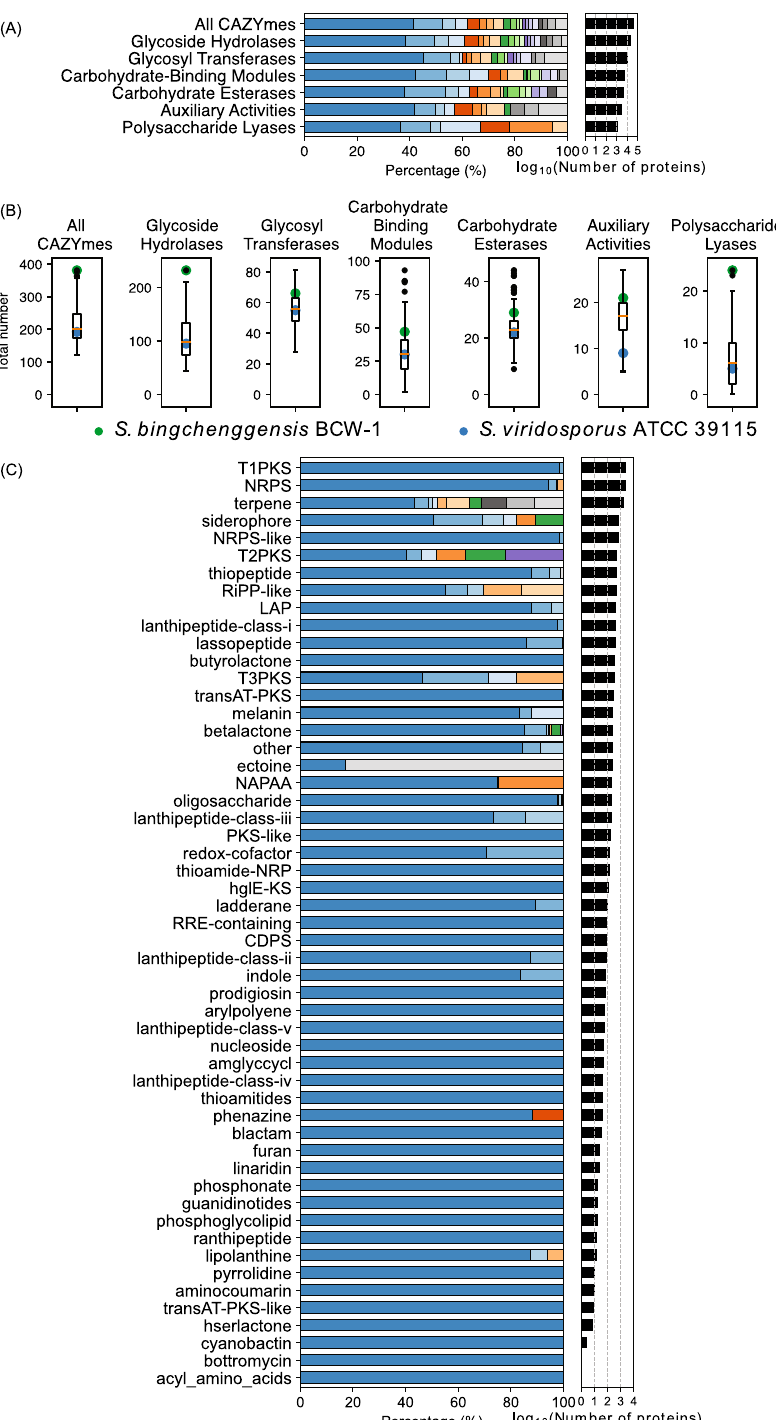
Figure 4. The total number of proteins in each CAZyme group ( A ) and antiSMASH BGC type ( C ) and the percentage in each conservation bin. ( B ) The total number of CAZymes and CAZyme groups encoded in each genome. The colour codes are the same as those in Fig.